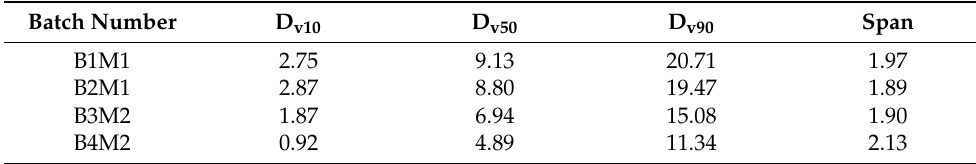
Table 3. Particle size distribution of the four α rifaximin samples expressed as volume diameter of the 10th, 50th, and 90th percentile of the distribution and span.